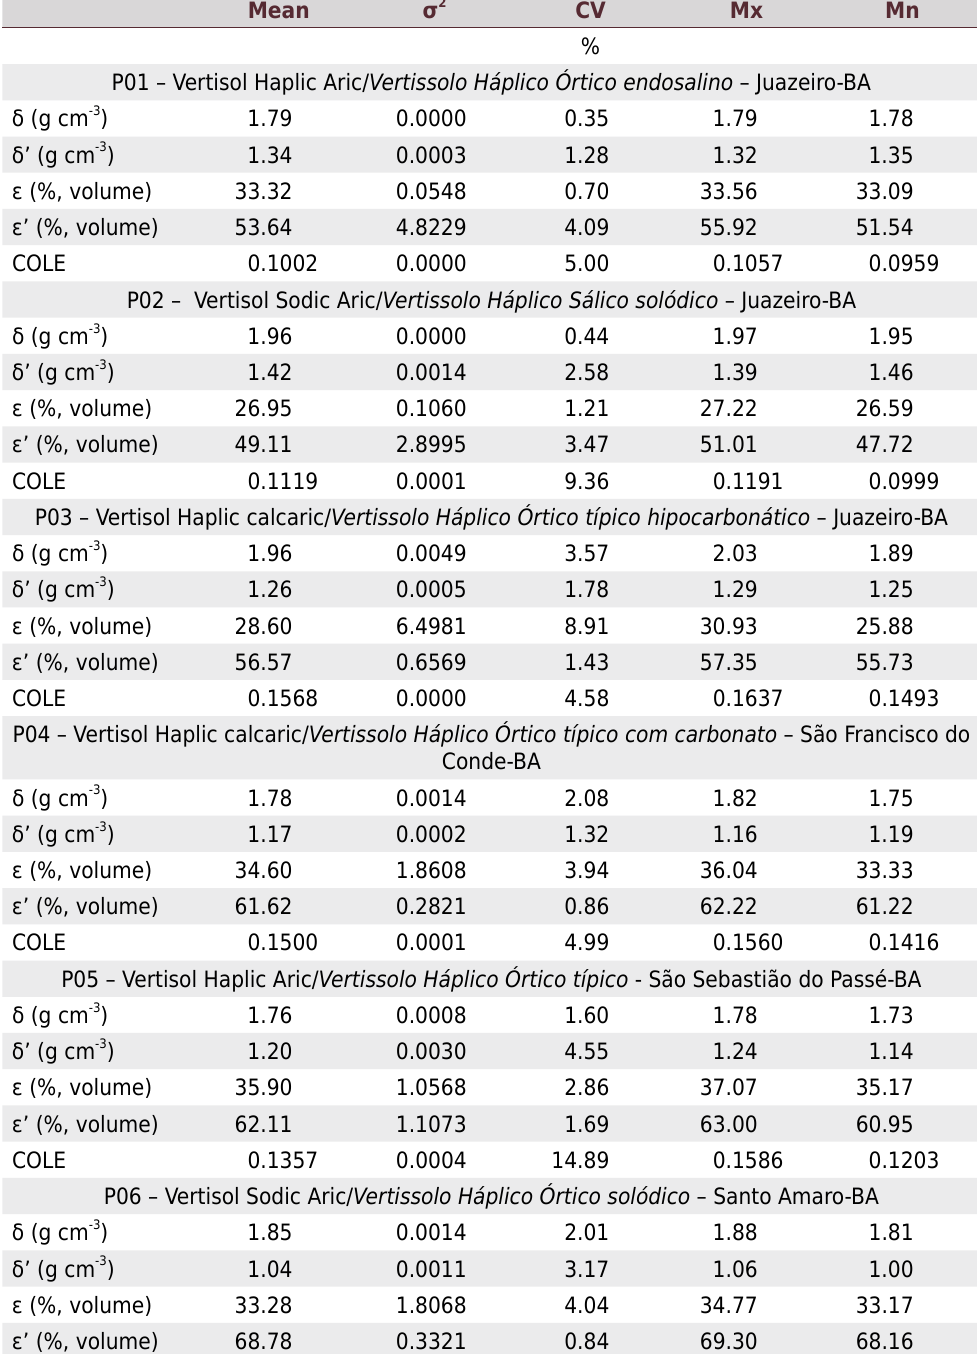
Table 6. Apparent specific mass, void index and COLE recorded for some kaolinite-rich Brazilian Vertisols Mean σ 2 CV Mx